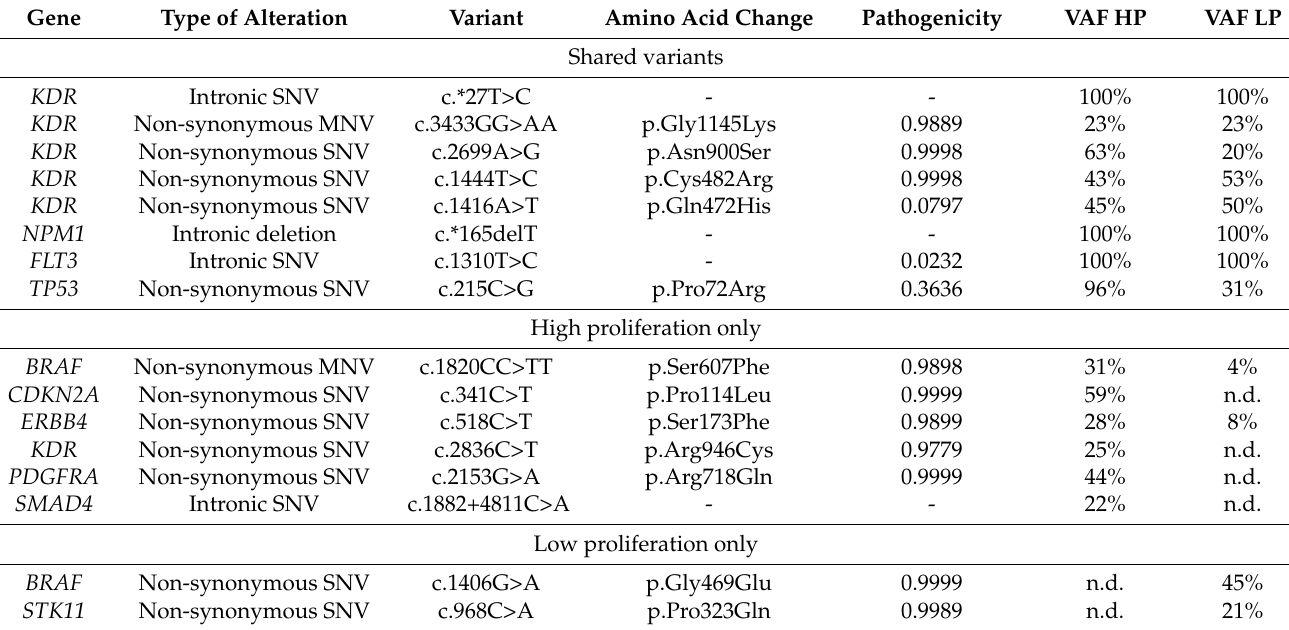
Table 3. Molecular characteristics of variants detected in tumor tissue of Patient 1.